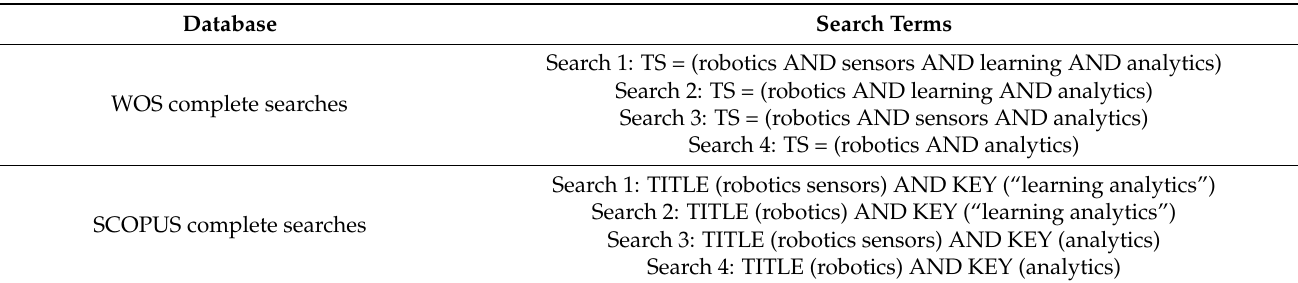
Table 2. Search terms and fields for Research Question